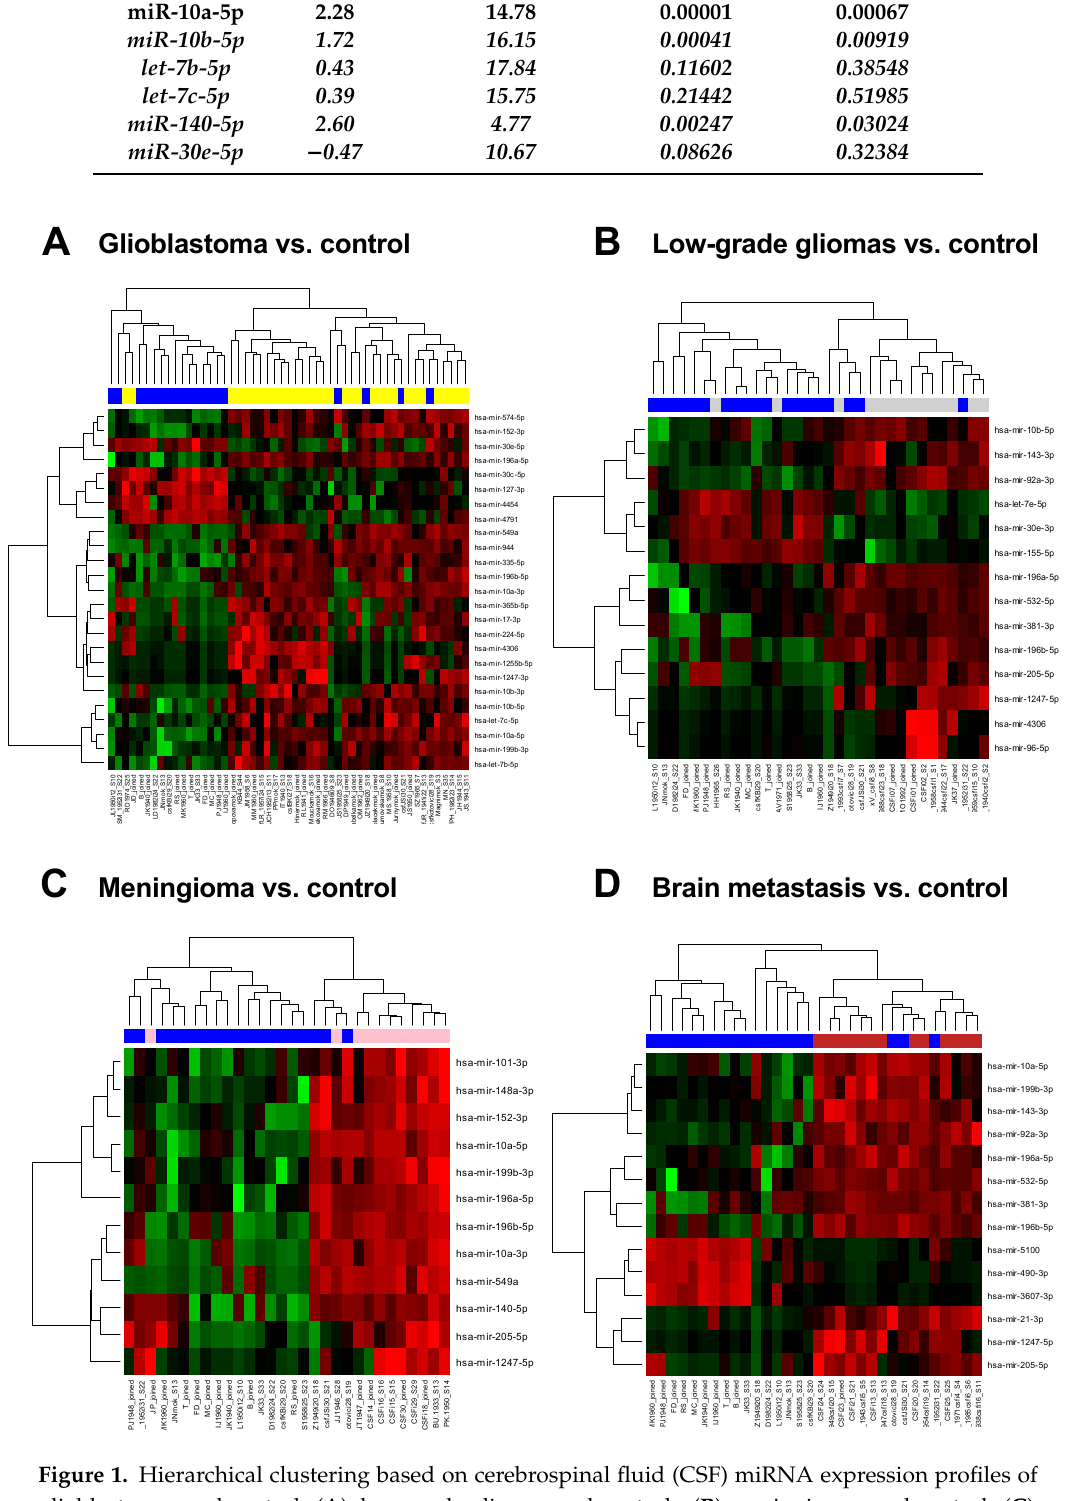
Figure 1. Hierarchical clustering based on cerebrospinal fluid (CSF) miRNA expression profiles of glioblastomas and controls ( A ); low-grade gliomas and controls; ( B ) meningiomas and controls ( C ); and brain metastases and controls ( D ). Blue color always indicates CSF specimen collected from control individual. A gradient of green and red colors is used in the heatmap (green color indicates lower expression whereas red color indicates higher expression of individual miRNAs in analyzed samples).